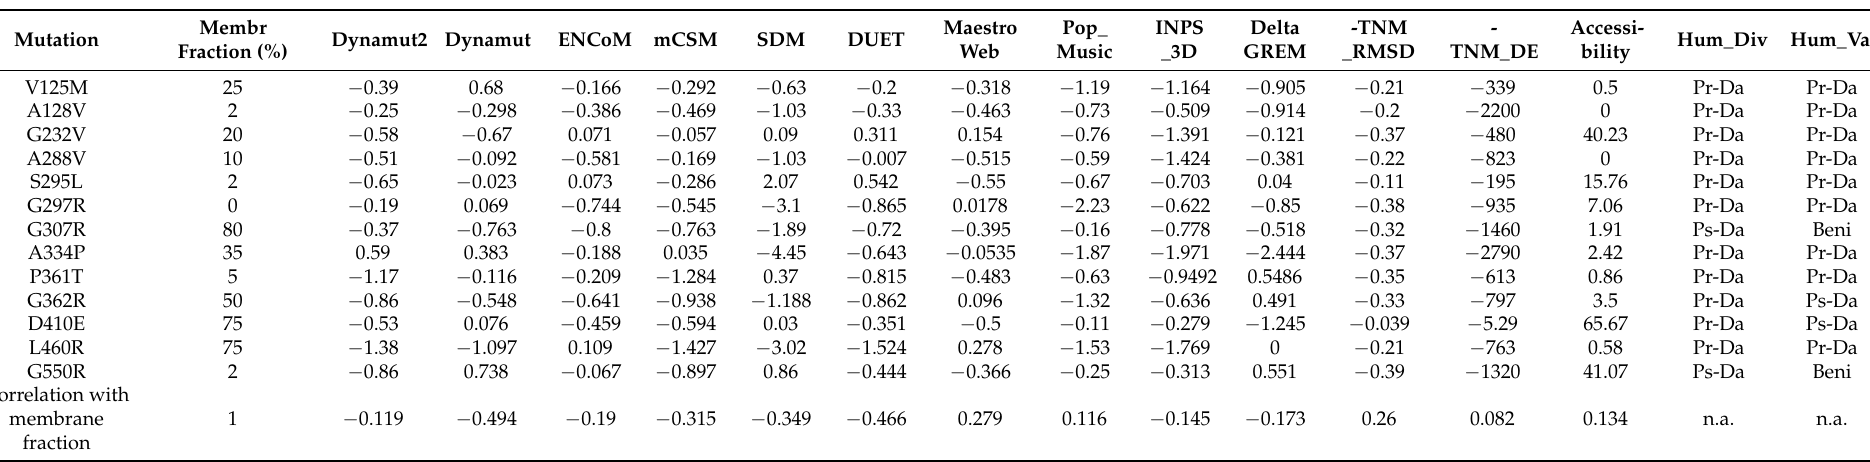
Table 2. Fraction of GAT-1 protein reaching the membrane in experimentally verified variants of the SLC6A1 gene, and ∆∆ G calculated by different bioinformatic methods. Negative values indicate destabilization of the protein. Correlation coefficients with membrane fraction are also calculated. Accessibility column corresponds to solvent accessibility calculated by Pop_Music. PrDa, probably damaging; Ps-Da, possibly damaging; Beni,